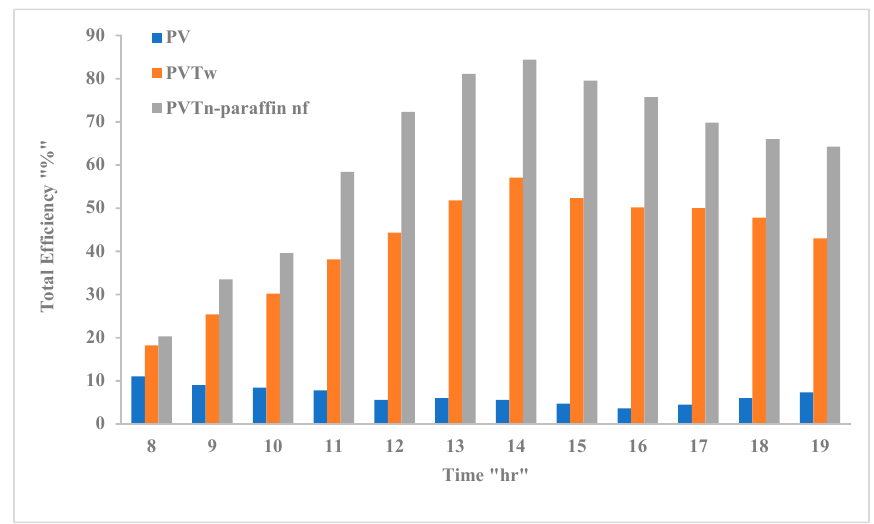
Figure 10. The total efficiencies of the tested systems variations with time.